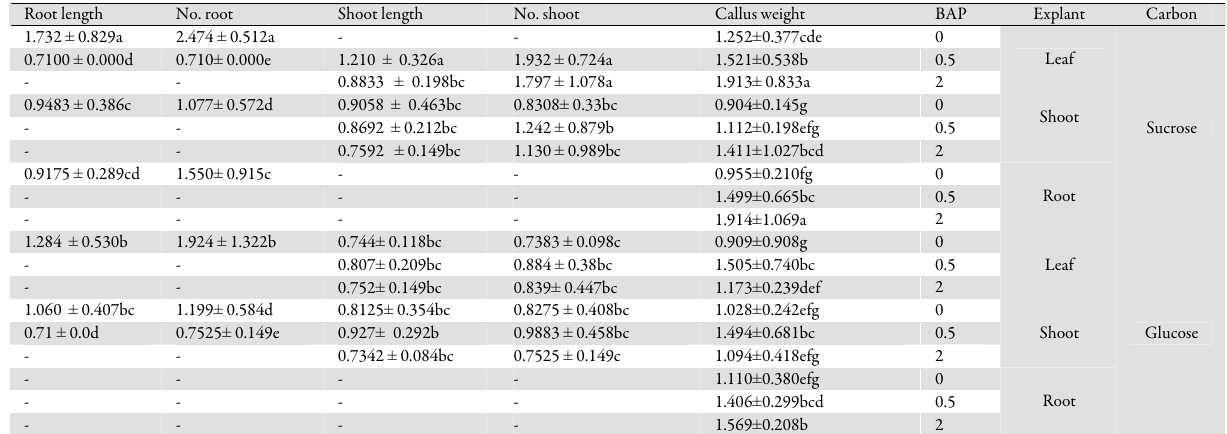
Table 11. The effect of interaction between BAP, explants and carbon on callus, shoot and root induction of A . annua on MS medium Root length No. root Shoot length No. shoot Callus weight